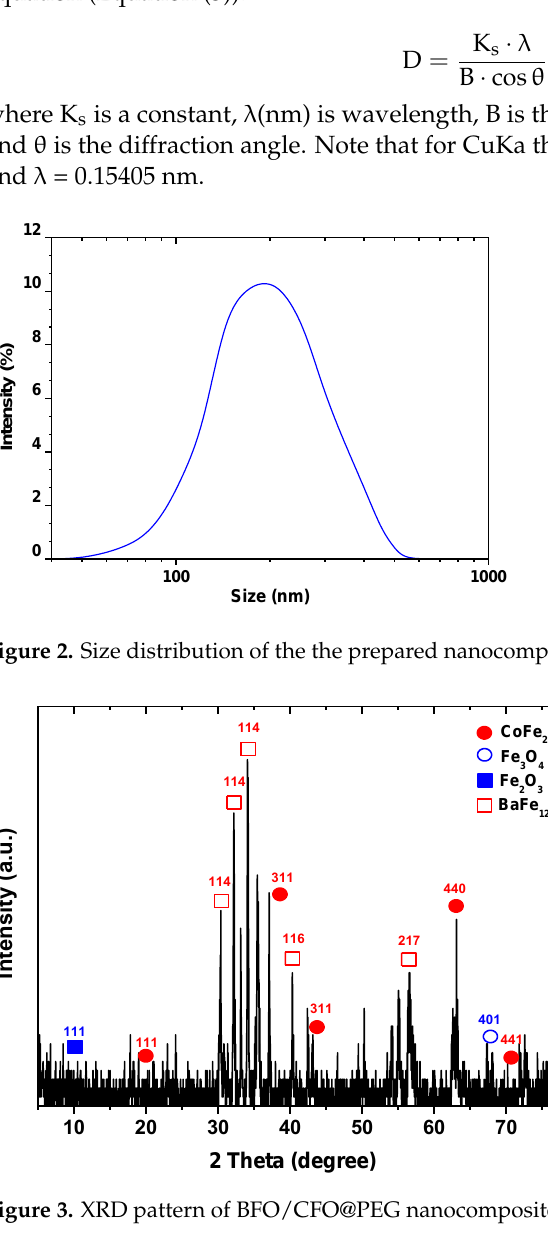
Applied magnetic field (Oe) Figure 4. VSM plot of BFO/CFO@PEG nanocomposites.